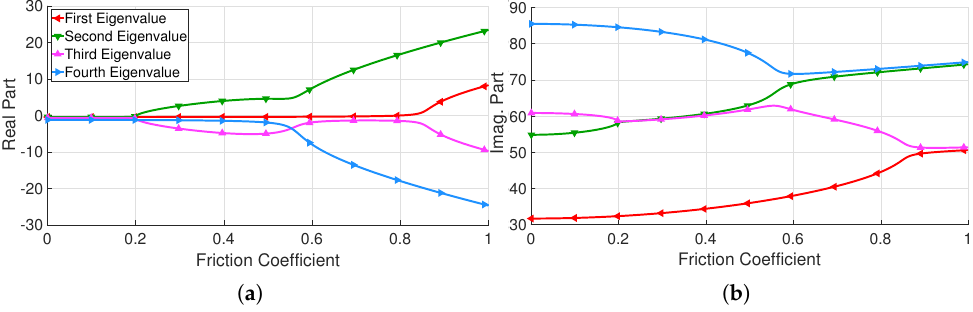
Figure 2. Evolution of the eigenvalue components with respect to the friction coefficient. ( a ) Real part, ( b ) imaginary The imaginary part evolutions of the model eigenvalues are relatively smooth and 113 present small nonlinearities. Conversely, the real part evolutions of the model eigenvalues 114 are more complex and exhibit non-stationary behaviour. Indeed, for instance, the first real 115 part eigenvalue is constant on the majority of the design space, except when the friction 116 coefficient µ is greater than 0.8.